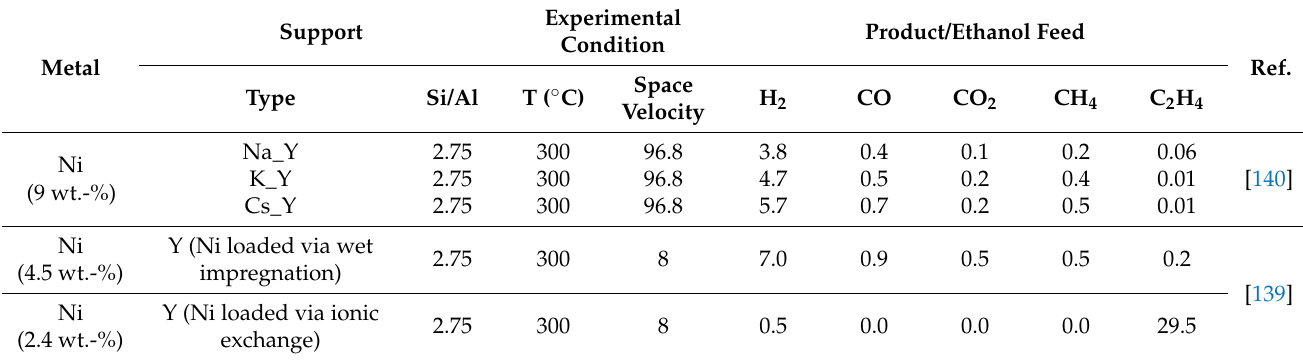
Table 4. Y-type zeolite-supported catalysts for